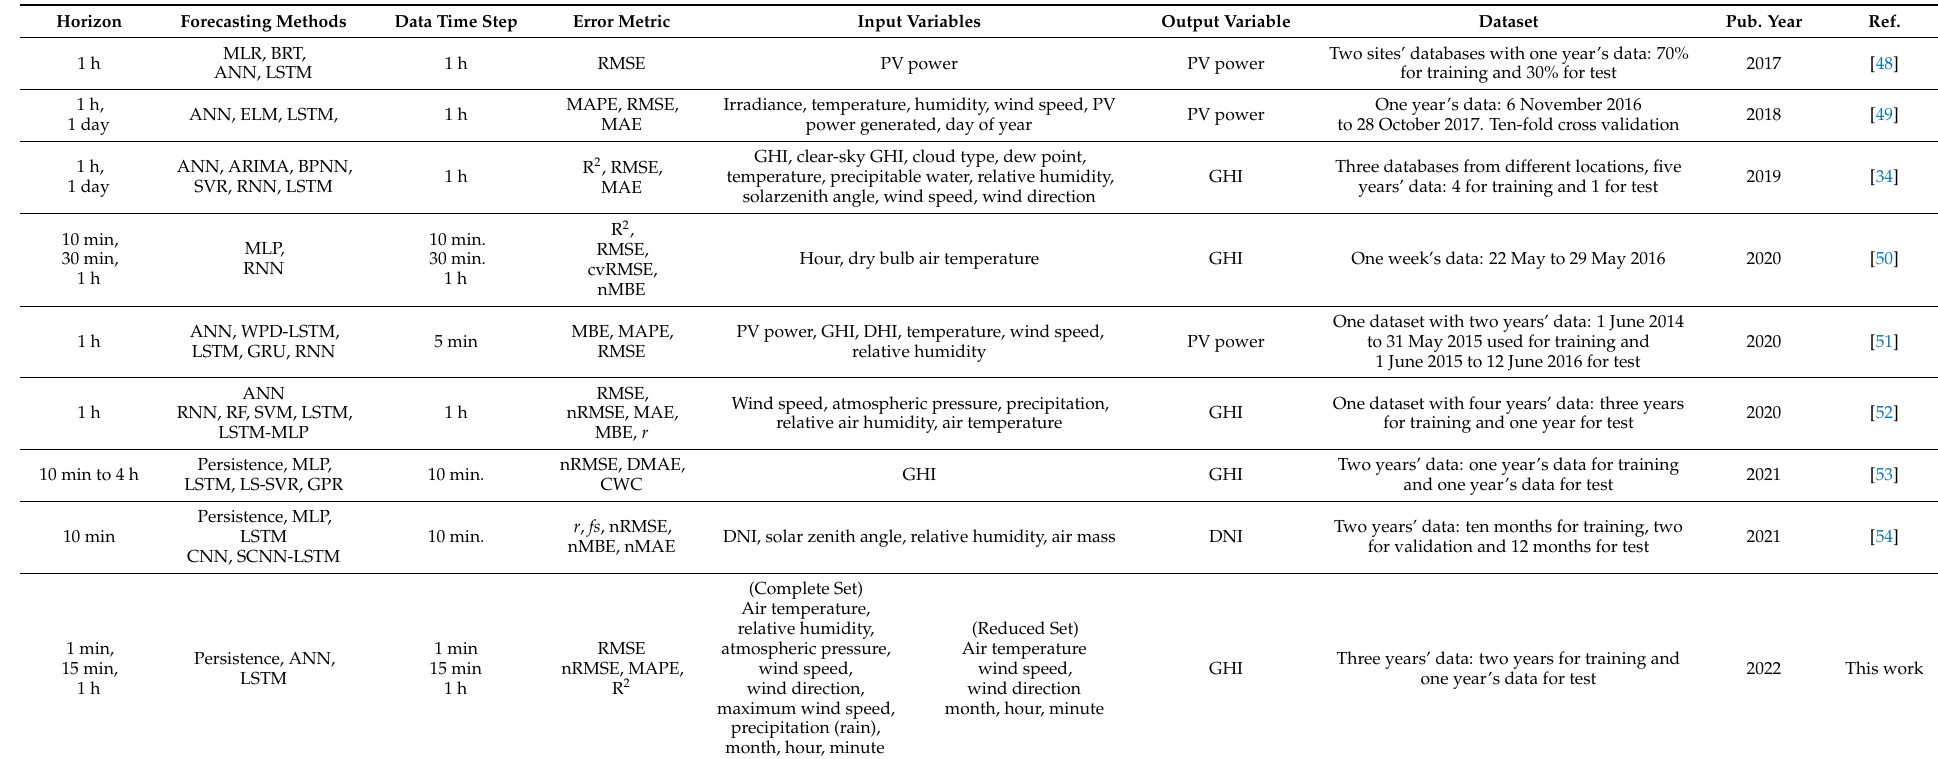
Table 1. Literature studies with simultaneous comparison between ANN and RNN or LSTM